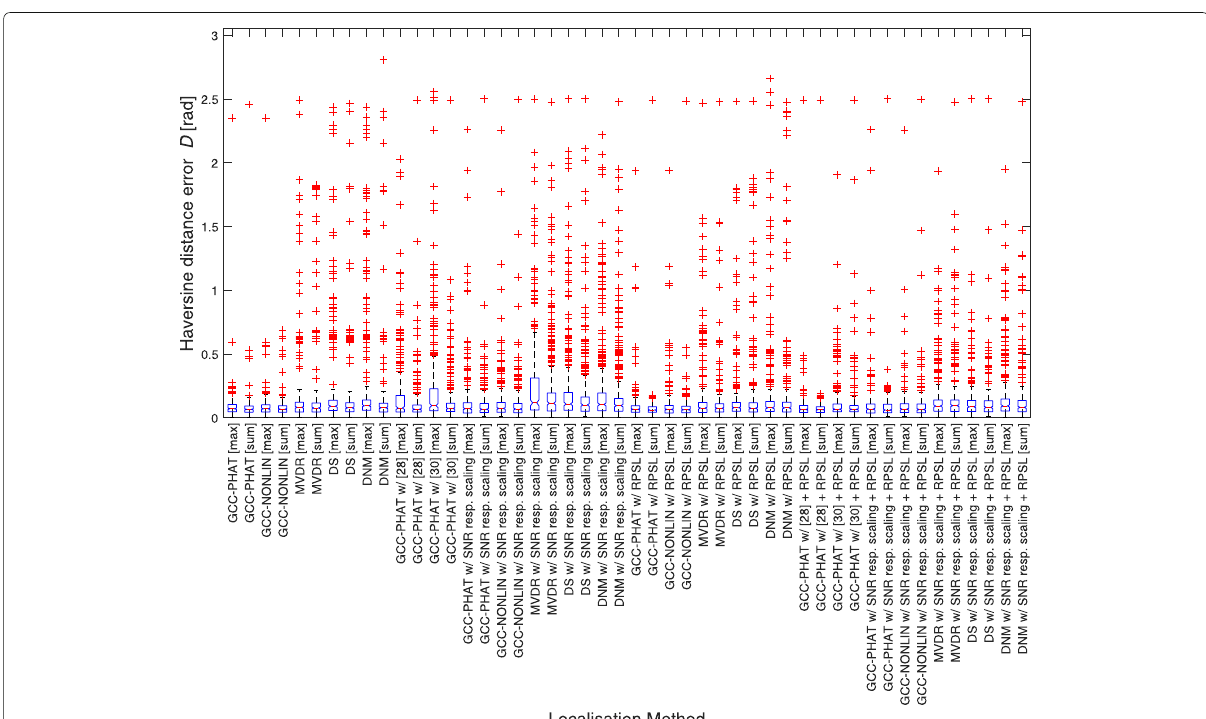
Fig. 10 Flying UAV—broadband sound source (task 2) haversine distance error distribution. Red line indicates the median, upper and lower edges of the blue box indicate the 75% and 25% quartiles, upper and lower black bars indicate the maximum and minimum, and upper and lower corners of the trapezoidal indicate the 95% upper and lower confidence limits